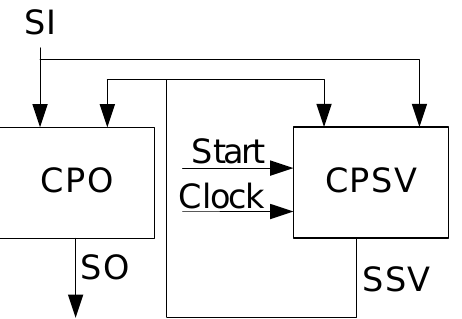
Figure 3. Structural diagram of LUT-based Mealy FSM A 1 . A block CPSV includes the hidden distributed register RG. The pulses Start and Clock control the operation of the RG. The LUTs of CPSV generate IMFs (3) entering the informational inputs of D flip-flops. As a result, the state variables v r ∈ SSV are generated. The block CPO generates outputs o w ∈ O represented by